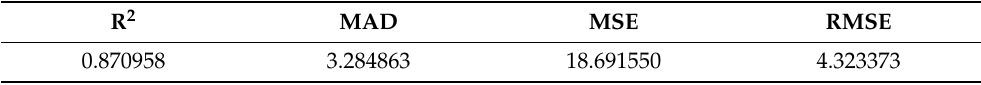
Table 3. Performance of the healthy predictor on rheumatoid arthritis dataset.